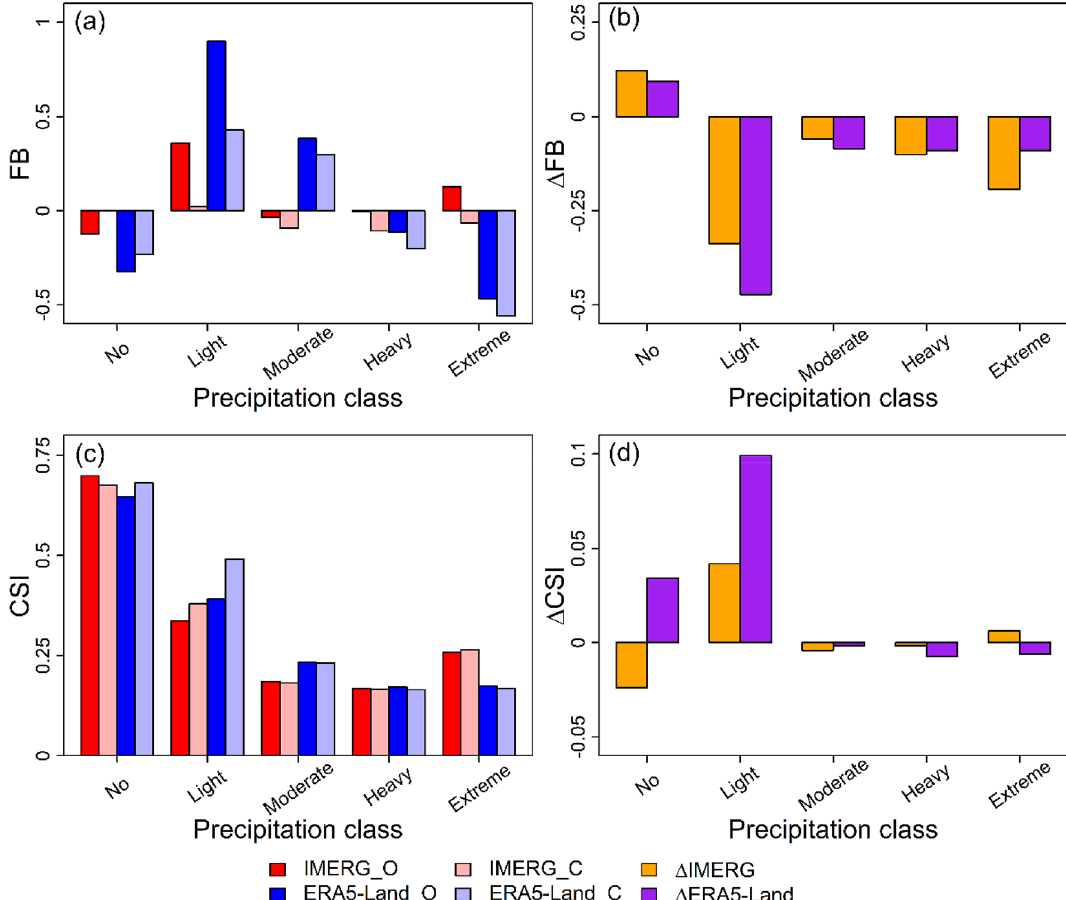
Figure 8. Bar chart of ( a ) FB (FB_O and FB_C), ( b ) ∆FB, ( c ) CSI (CSI_O and CSI_C), and ( d ) ∆CSI for IMERG and ERA5-Land in different precipitation